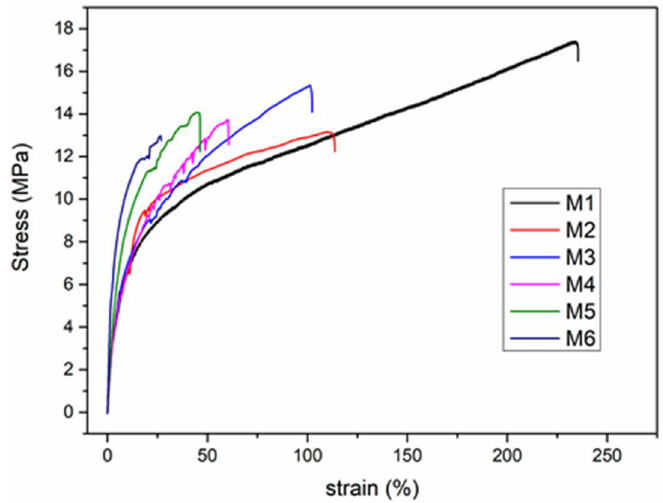
Figure 9. Typical stress–strain curves of M1–M6 membranes.